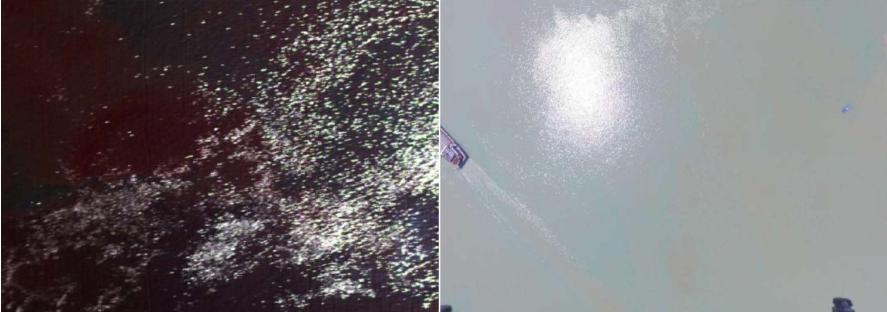
Figure 7. The images obtained at noon. The sunlight reflection is